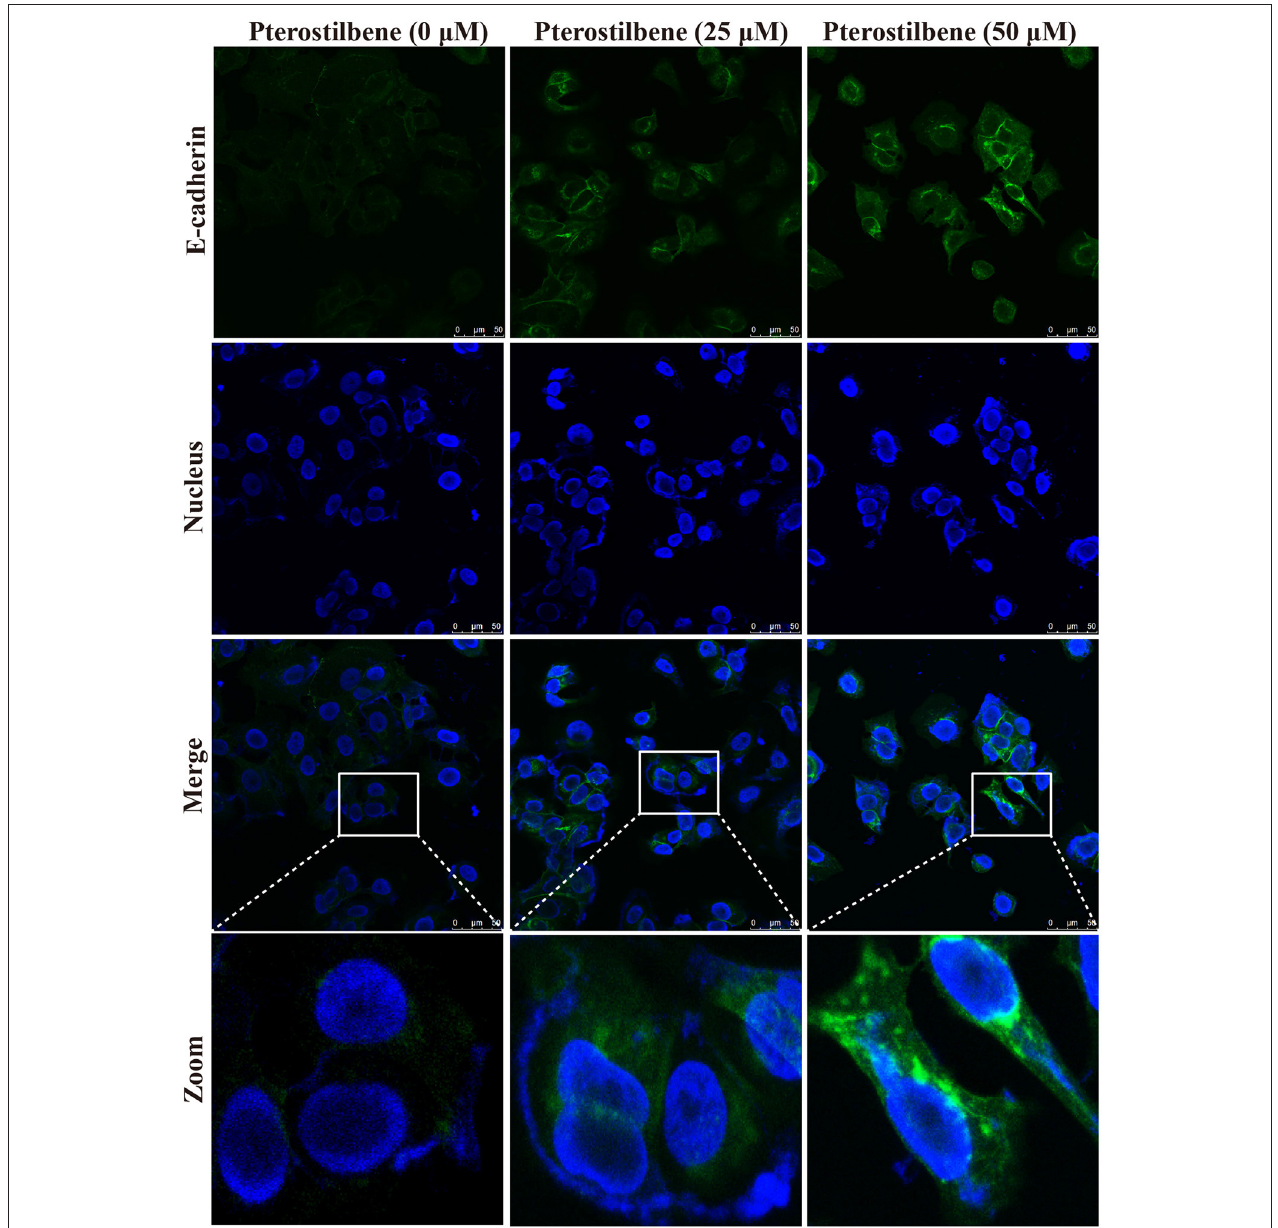
FIGURE 5 | Pterostilbene influenced the expression of E-cadherin. Cells were treated with different concentrations of pterostilbene for 24h with immunofluorescence observed using confocal fluorescence